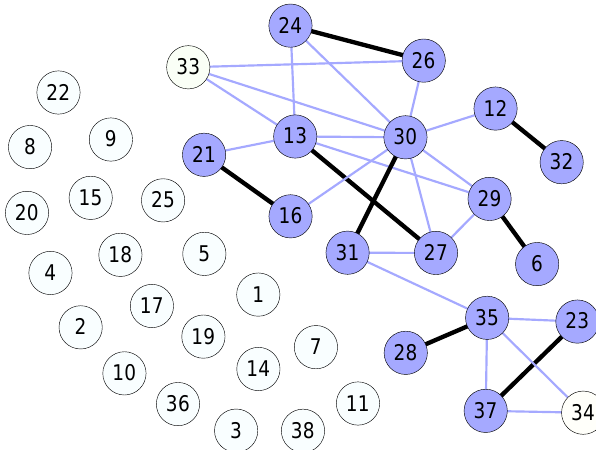
Figure 3. Graph model for the priority mechanism, with links indicating mutually compatible pairs and bold link indicating an efficient matching. The priority ordering is based on the PRA level.